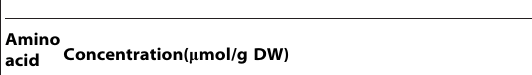
Table 1. Amino acid contents in the leaves of wild-type and transgenic alfalfa plants over-expressing AK and APR.